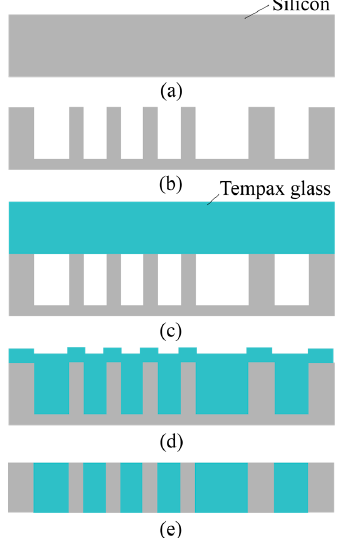
Figure 10. Glass reflow process. ( a ) Silicon wafer; ( b ) deep RIE; ( c ) anodic bonding in a high vacuum chamber; ( d ) glass reflow process; ( e ) CMP.